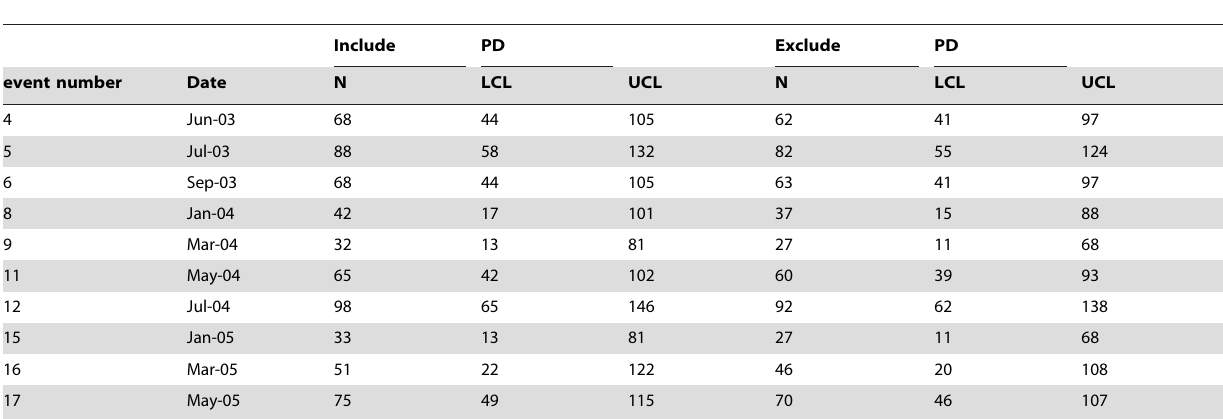
Table 1. Mark-resight model parameter estimates, and 95% lower (LCL) and upper (UCL) confidence levels for abundance parameters for 10 primary